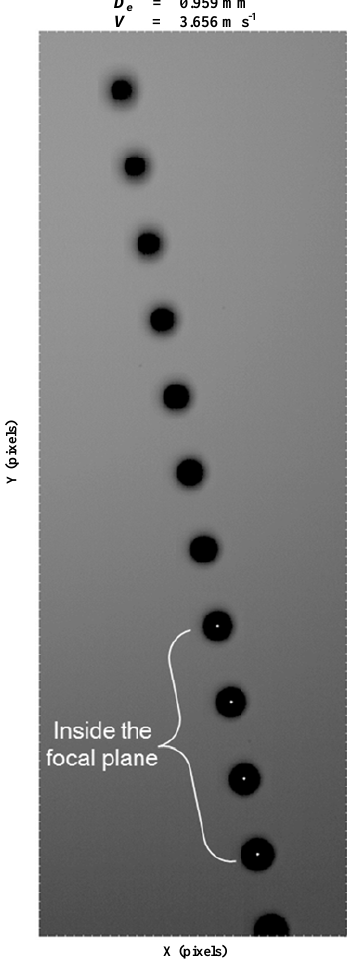
Figure 9. Multiple sequences of the photographed images for a se- lected natural water drop ( D e = 0.96mm) as it was initially out of the focal area with blurred drop outline in the upper portion of the view frame and then moved into the focal zone with sharp and clear drop outline in the lower portion of the view